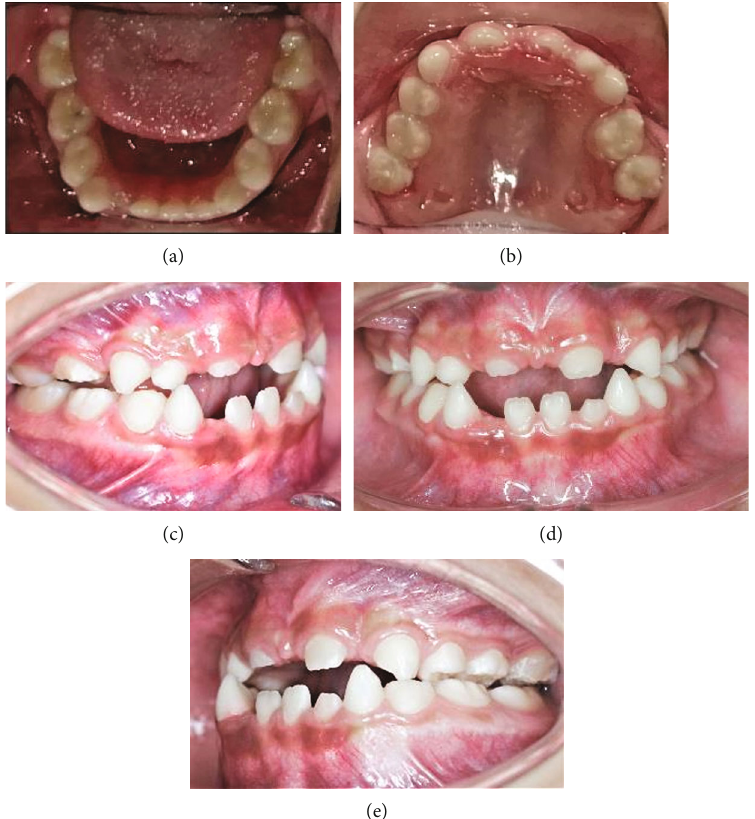
Figure 5: Asymmetrical oval arches and dental malocclusion Class III are shown (a and b). Traction upper labial frenulum associated with lack of vertical development of the superior alveolar process is observed (c, d, and e).